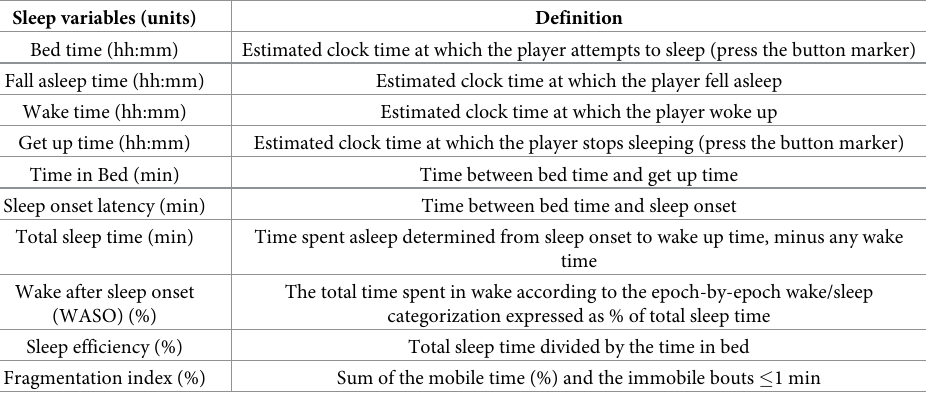
Table 2. Definitions of each sleep variable derived from the wrist watch